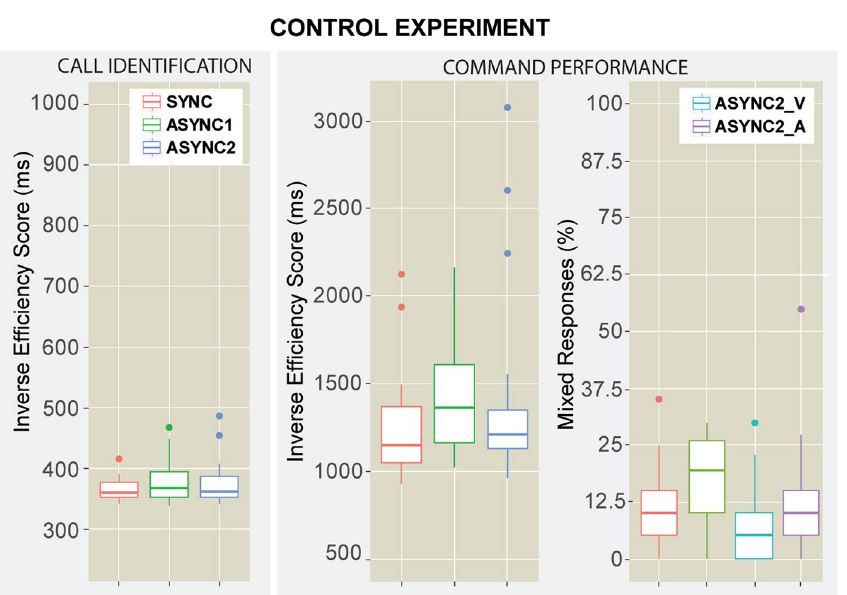
Figure 2. Control Experiment Results. Box-plots representing the Inverse Efficiency Score (IES) for the AVS conditions: SYNC , ASYNC 1, ASYNC 2. On the left the CALL identification IES, on the right the COMMAND performance and % of mixed responses ( SYNC , ASYNC 1, ASYNC 2 V , ASYNC 2 A